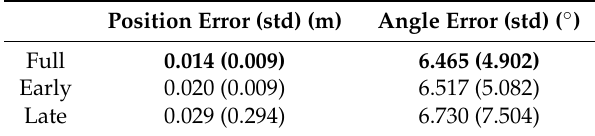
Table 3. Validation set mean error for DNN architecture